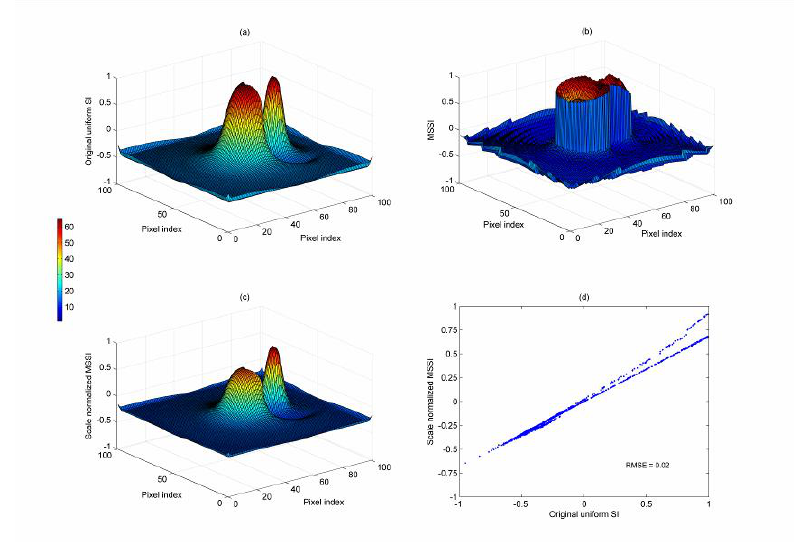
Figure 4: The SI and the MSSI. (a) The SI applied directly on the sample surface at a uniform scale. (b) The MSSI of the surface. (c) The recovered SI from the MSSI by scale normalization. And (d) the SI and scale normalized MSSI